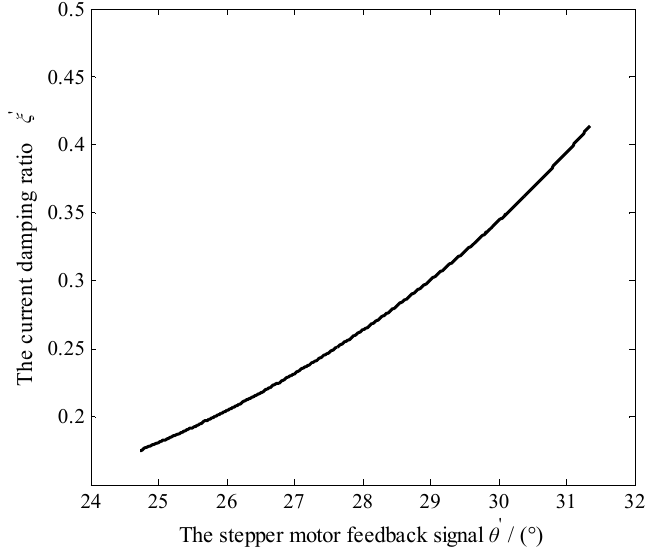
Figure 5. The curve of the current damping ratio ξ ’ vs. the stepper motor feedback signal θ